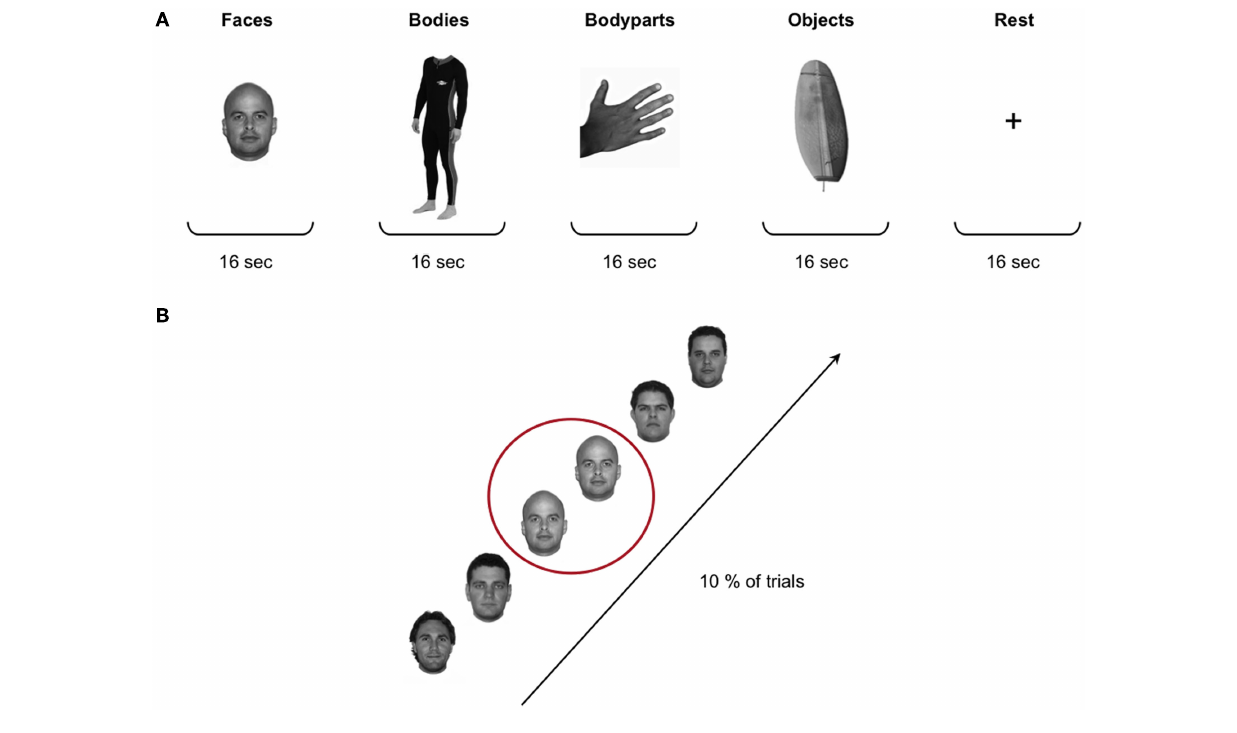
FIGURE 1 | Localizer stimuli and design. (A) Stimuli for the localizer task were grayscale photographs of faces, headless bodies, individual body-parts (hand and feet), and objects.The four stimulus categories were presented in a blocked design, with a total of 32 blocks of 16s each. In between each stimulus block participants were presented with a 16-s rest block during